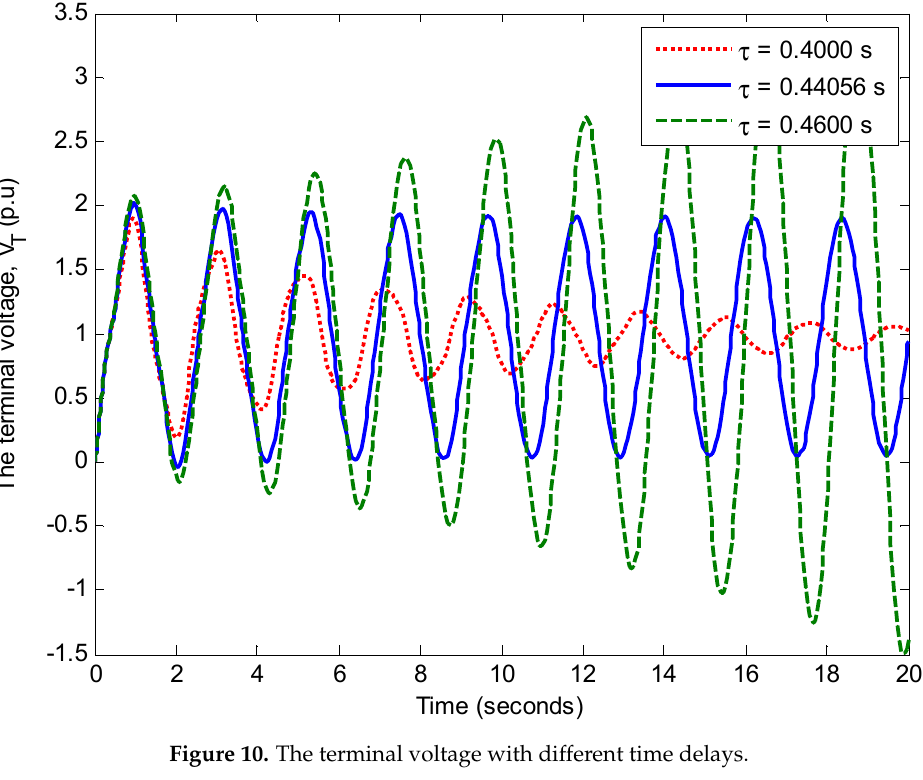
Energies 2018 , 11 , x FOR PEER REVIEW Figure 10. The terminal voltage with different time delays. Figure 10. The terminal voltage with different time delays.